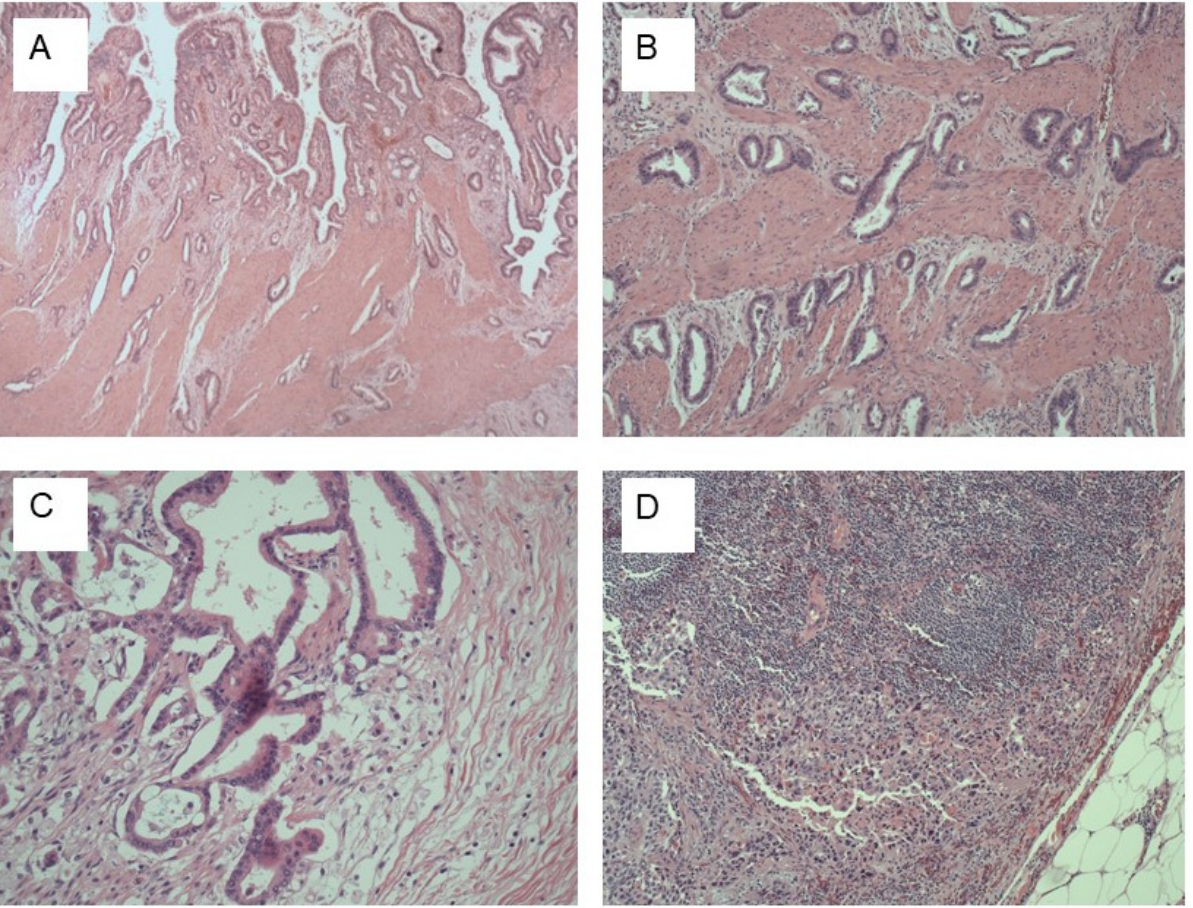
Figure 1. Gallbladder cancer (GBC) Histology: ( A ) GBC, biliary type, infiltrating gallbladder (GB) wall. The top of the image shows normal GB mucosa, H&E stain, ×40; ( B ) gallbladder carcinoma invading muscularis propria, H&E stain, ×100; ( C ) perineural invasion, H&E stain, ×100; ( D ): Metastatic high-grade GBC to lymph node, H&E stains, G- ×100, H- ×400.